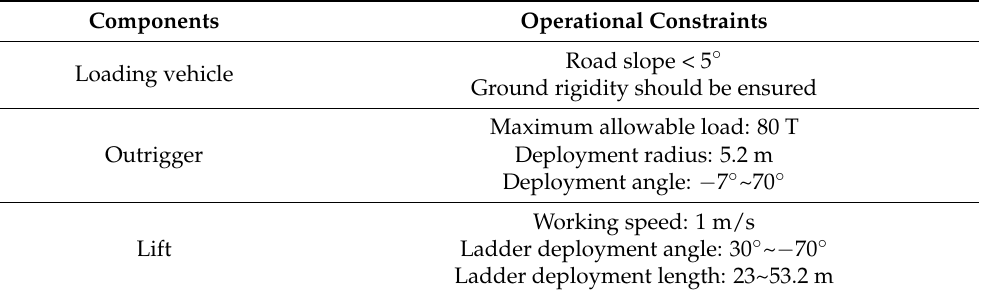
Table 1. Safe operational conditions for elevated ladder of fire truck.